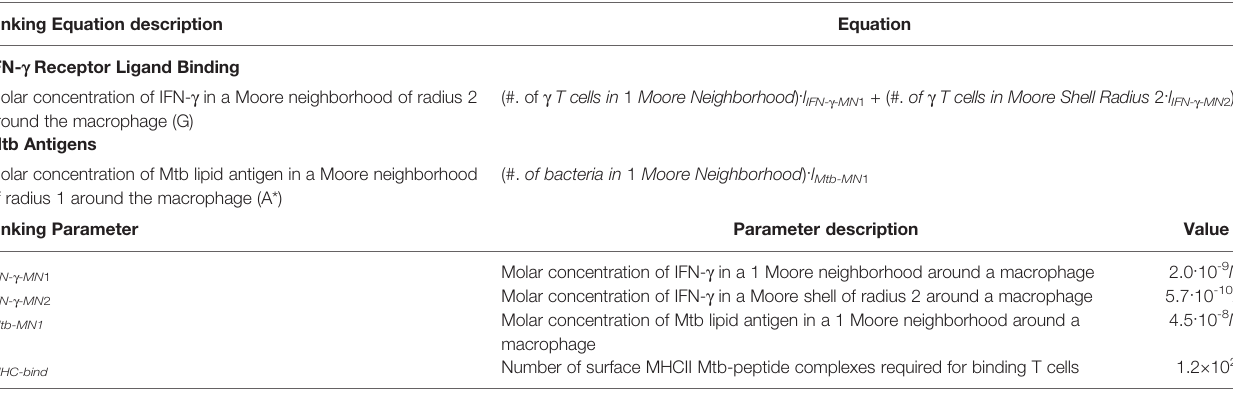
TABLE 1 | Equations and parameters for the new linking that are needed to combine the intracellular-scale model and GranSim . Linking Equation